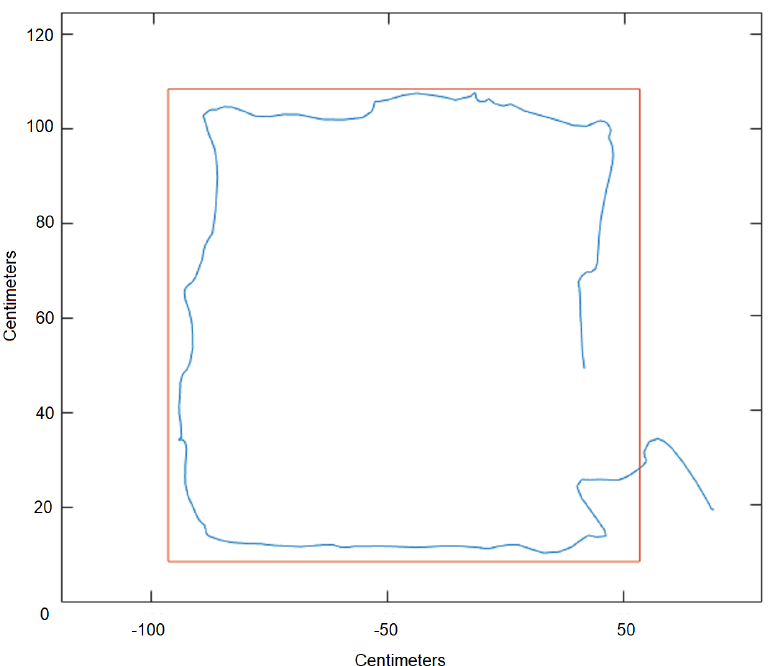
Figure 5. The graph shows the 2D track view on a test square task. The blue line is the path that the patient had to follow, the red line is the executed path by the patient. Track on a test square Task (2D